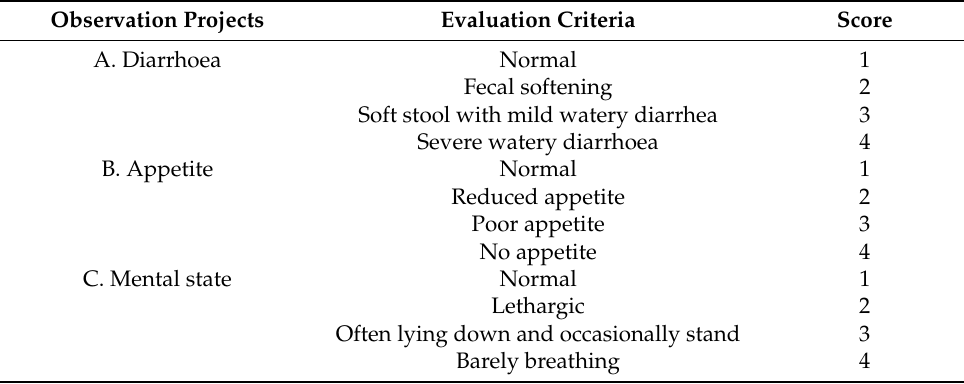
Table 1. Scoring criteria for clinical symptoms in infected piglets.